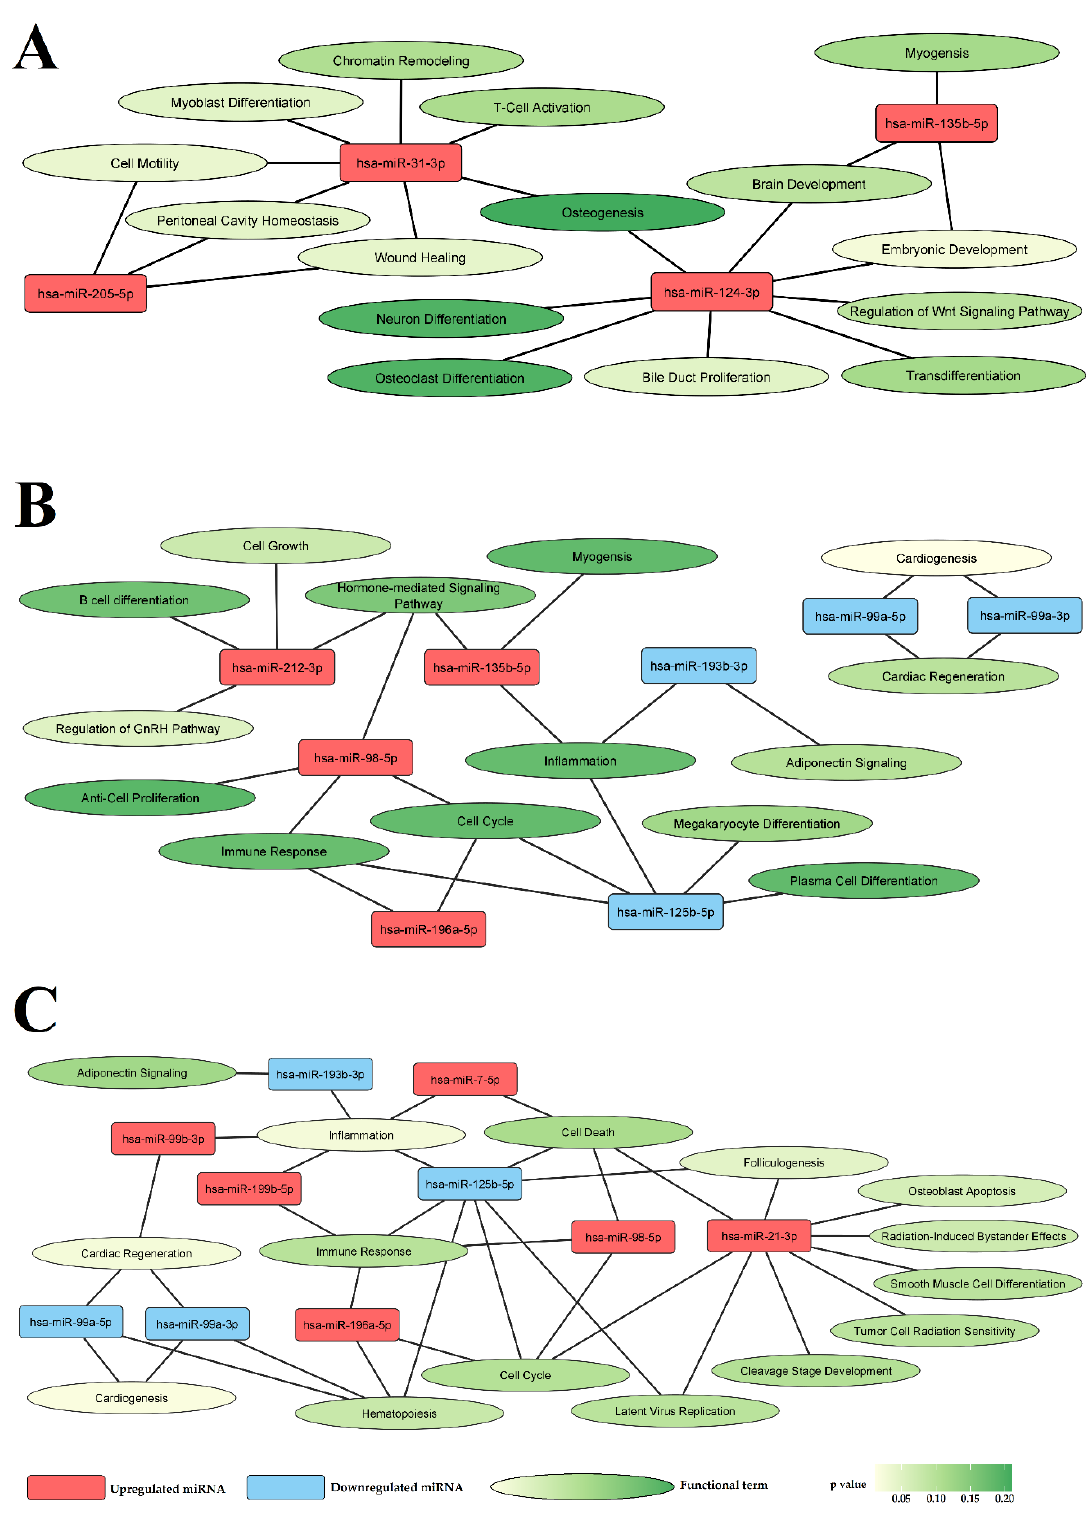
Figure 2. The functional network of miRNAs selected from pairwise comparisons among the LEAD, AAA, and CVD groups. ( A ) Network for miRNAs selected from the LEAD vs. AAA comparison. ( B ) Network for miRNAs selected from the LEAD vs. CVD comparison. ( C ) Network for miRNAs selected from the AAA vs. CVD comparison. Each panel presents the top 15 most enriched functional terms (with the lowest p -value of enrichment) of ‘miRNA Function’ category in the miRNet 2.0 tool as well as associated miRNAs. AAA — abdominal aortic aneurysm, CVD — chronic venous disease, LEAD — lower extremity artery disease.